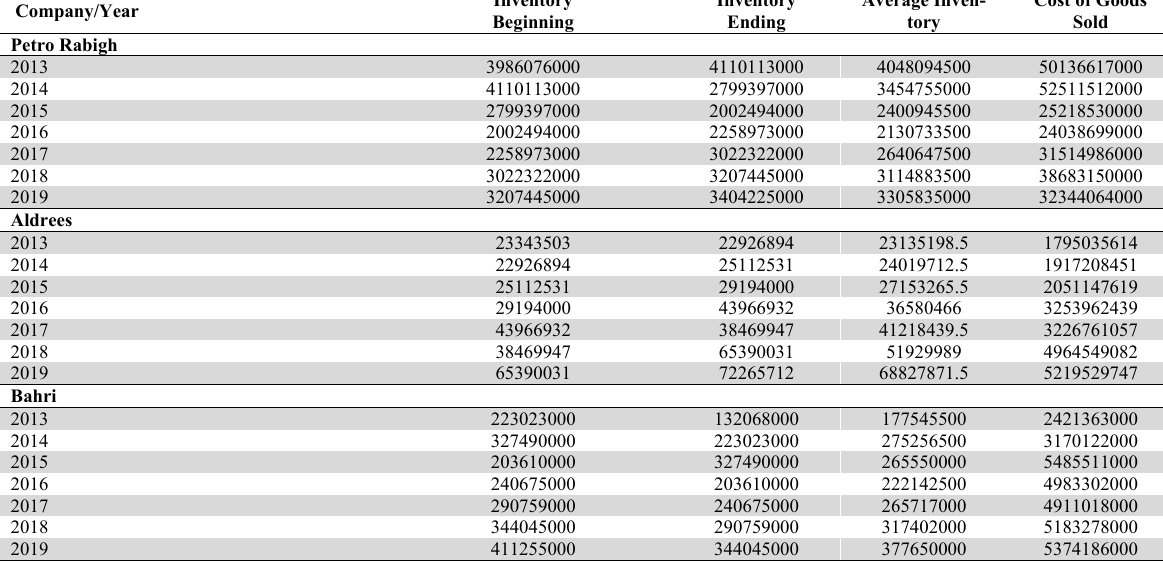
Inventory – Beginning, ending and average Company/Year